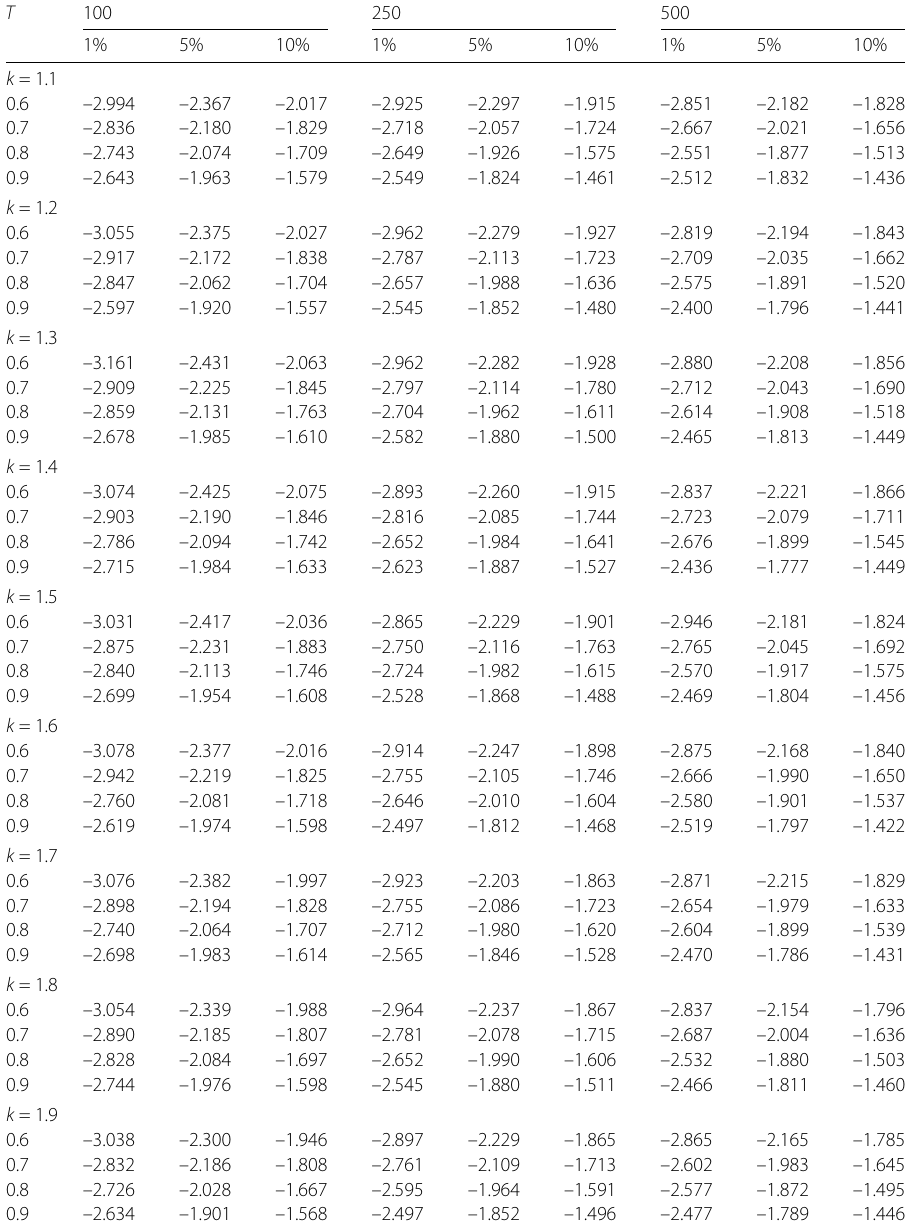
Table B2 Critical values for FI models only intercept included in fractional frequency Fourier function d = (0.6,0.9)